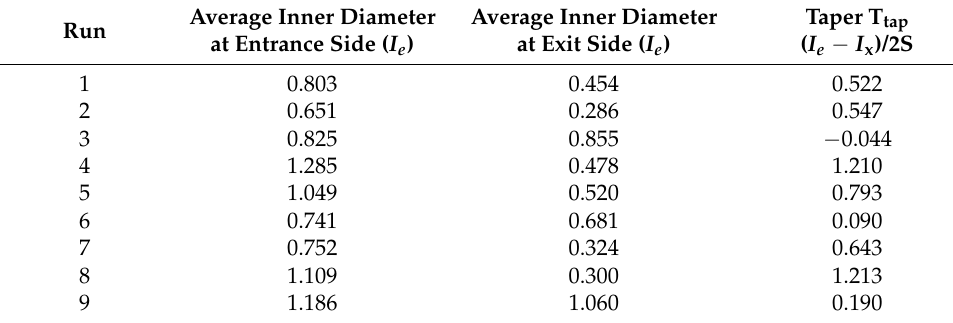
Table A3. Measured data and quality calculation results for